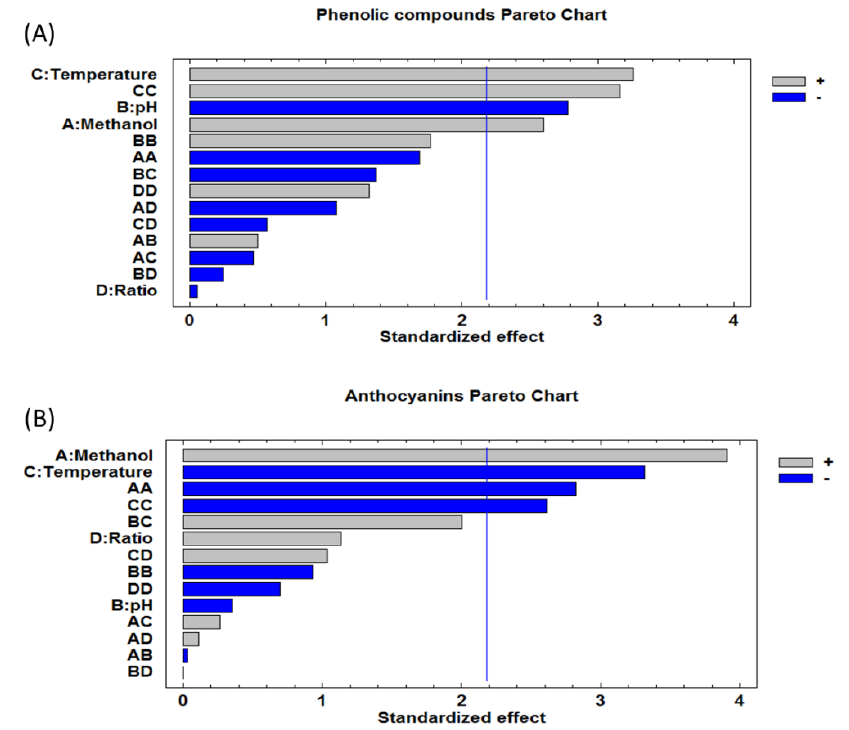
Figure 2. Pareto charts for the standardized effects: ( A ) total phenolic compounds and ( B ) total anthocyanins.